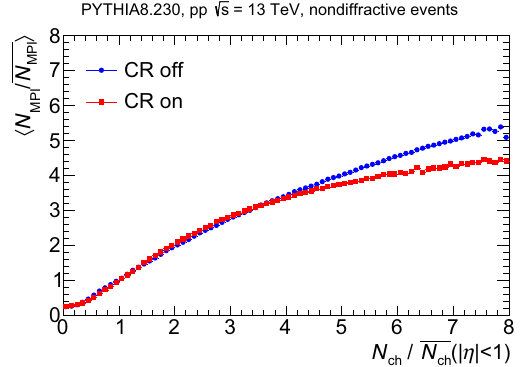
Mean self-normalized number of MPI as a function of self-normalized charged-particle multiplicity in | η | < 1 in PYTHIA8